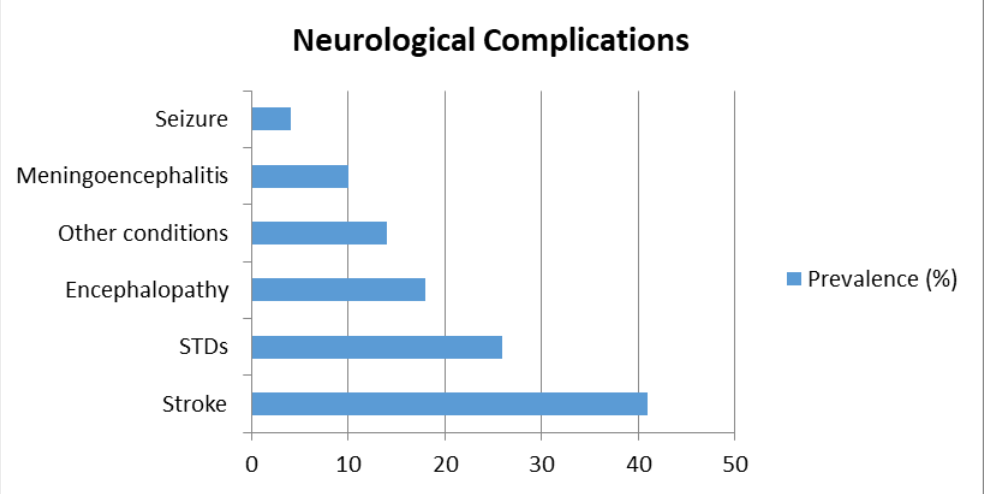
Figure 2. The prevalence of the main neurological complications of SARS-CoV-2 infection reported by the analyzed studies were: stroke (41%); STDs (26%); encephalopathy (18%); meningoencephalitis (10%); seizures (4%); and other conditions (14%), which included impaired consciousness, brain edema, headache, dizziness, acute mania, intracranial hypertension, EEG alterations, brain demyelination and vasculopathy.